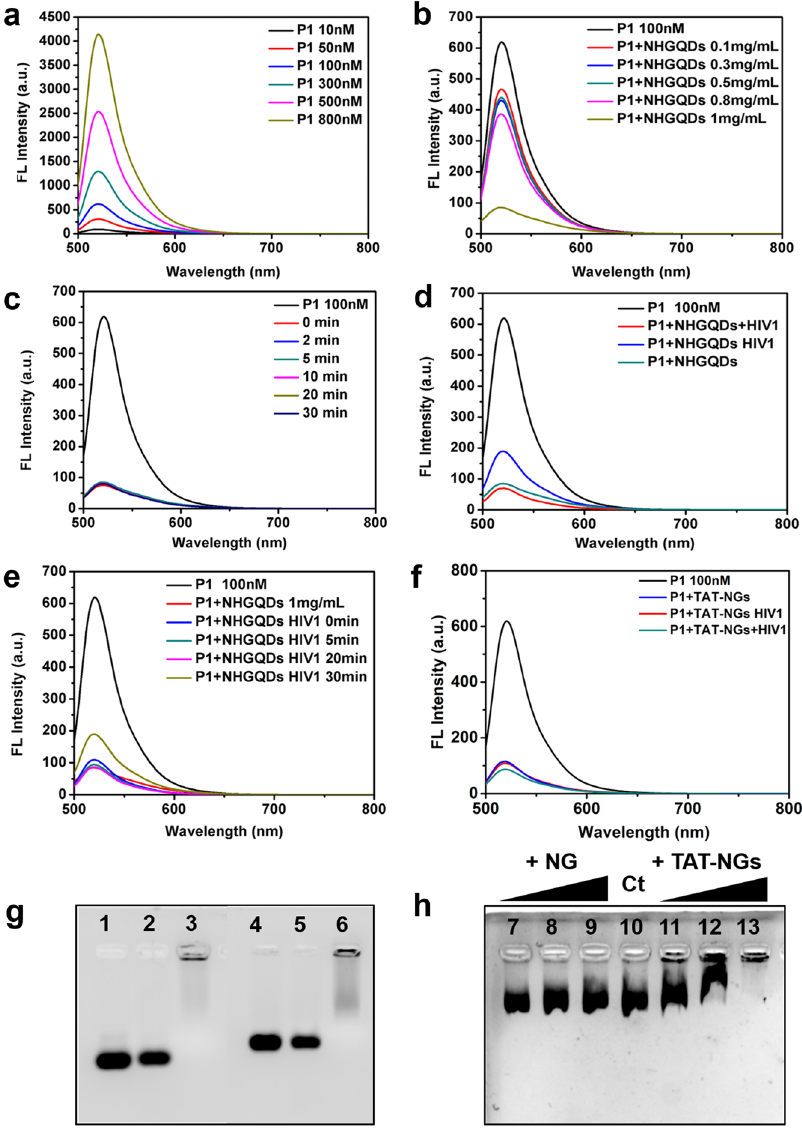
Fig. 7 The interaction between NH-GQDs derivatives and DNA. a The FLE spectra of P1 at different concentrations. b – e The FLE spectra of P1 under different conditions. ( b) P1 mixed with different concentrations of NH-GQDs. ( c ) The fl uorescence quenching of P1 + NH-GQDs (1 mg mL − 1 ) as a function of time. ( d ) The fl uorescence intensity of ‘ P1 + NH-GQDs HIV1 ’ and P1 + NH-GQDs + HIV1 . ( e ) The fl uorescence restoration of P1 + NH-GQDs quenched by HIV1 as a function of time. f The fl uorescence intensity of P1 , P1 + TAT-NGs (10:1), P1 + TAT-NGs (10:1) + HIV1 , or ‘ P1 + TAT-NGs (10:1) HIV1 ’ . g Gel electrophoresis diagram of P2 (line 1) in addition with NH-GQDs (1 mg mL − 1 , line 2) or with TAT-NGs (10:1) (1 mg mL − 1 , line 3); gel electrophoresis diagram of P3 (line 4) in addition with NH-GQDs (1 mg mL − 1 , line 5) or with TAT-NGs (10:1) (1 mg mL − 1 , line 6). h Gel electrophoresis diagram of PL (line 10) in addition with different concentrations of NH-GQDs (line 7: 1 μ g, line 8: 2 μ g, and line 9: 5 μ g) or with different concentrations of TAT-NGs (10:1)